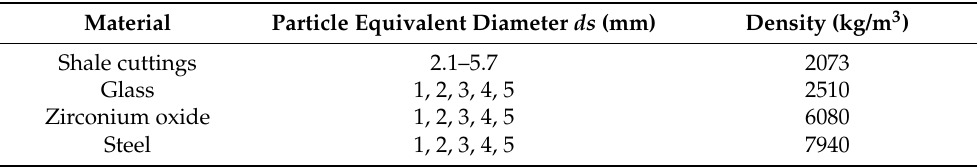
Table 1. Main physical parameters of particles involved in